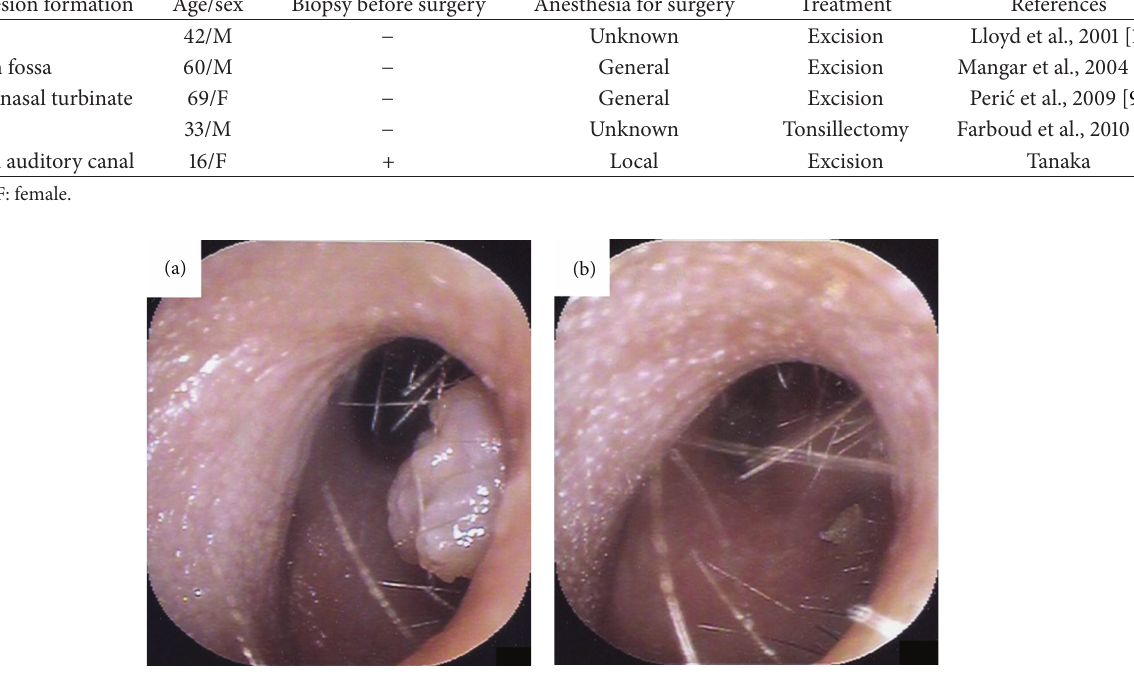
diagnosis of fibroepithelial